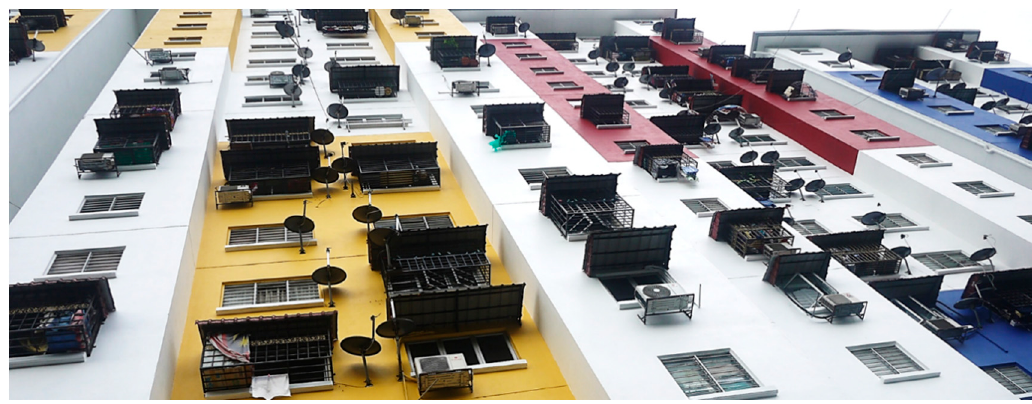
Figure 1. High-rise social housing in Kuala Lumpur.